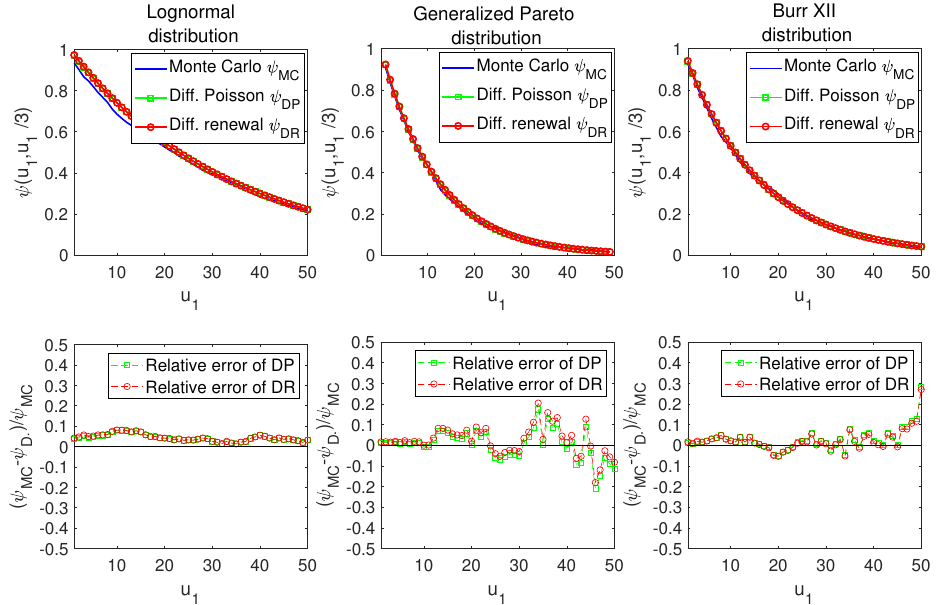
Figure 4. Ruin probabilities ( top panels) for the insurer–reinsurer model in the infinite-time horizon calculated using Monte Carlo (MC) simulations with the renewal process with α = 10, σ M = 0.1, the diffusion approximation with the Poisson process (DP) with λ = 10 and the diffusion approximation with the renewal process (DR) for selected heavy-tailed distributions. Respective relative errors ( bottom panels) of the approximations. In the simulations, the number of MC iterations is 10,000, parameters of claim distributions are given by Equations